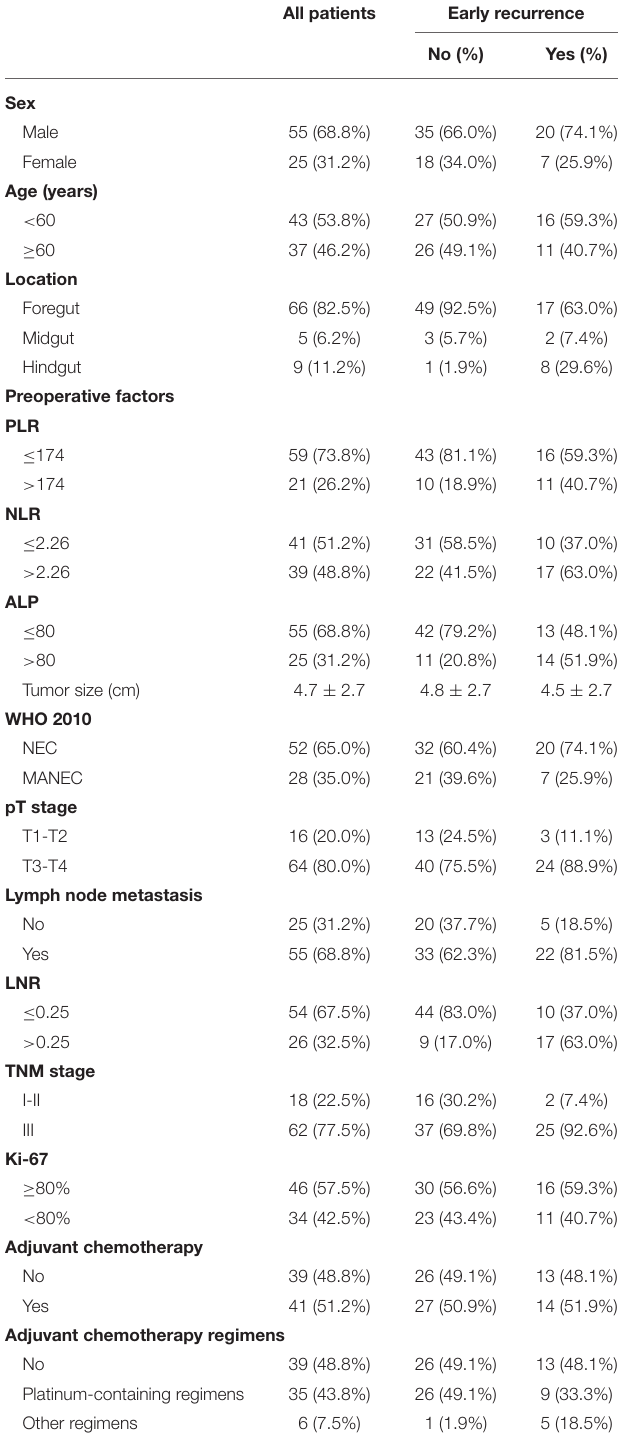
TABLE 1 | Demographic characteristics of all the patients. TABLE 2 | Univariate analysis of the risk factors associated with early recurrence for GI-PDNEN.